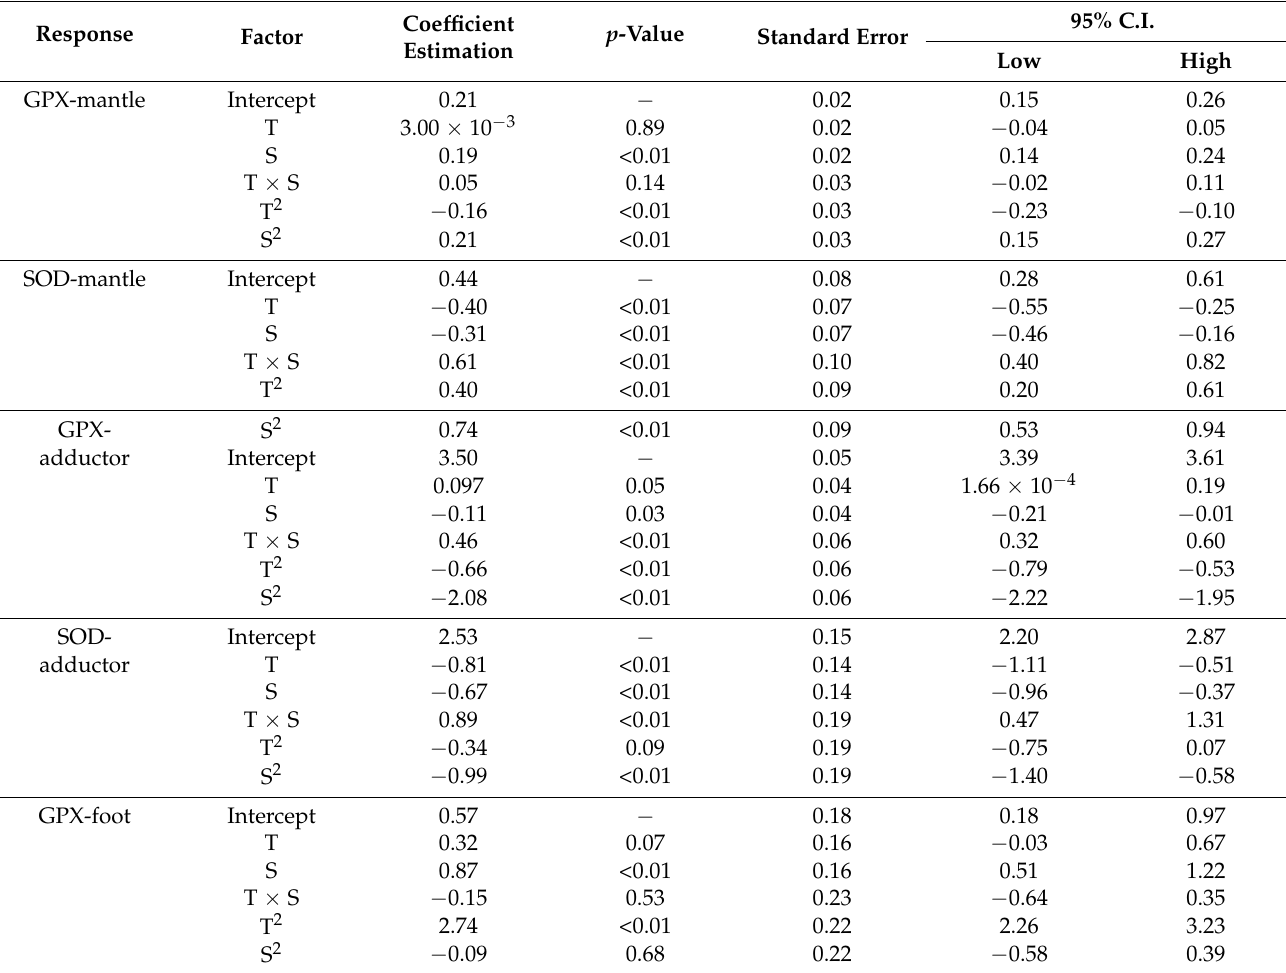
Table 8. Coefficient estimation of the antioxidant gene expression index prediction